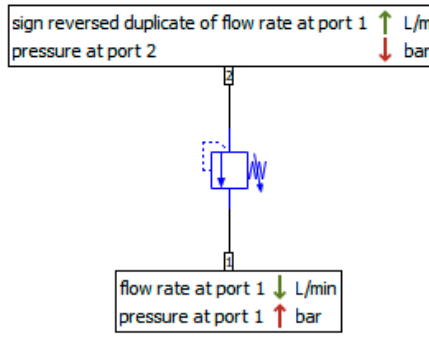
Figure 9. One-way valve model.